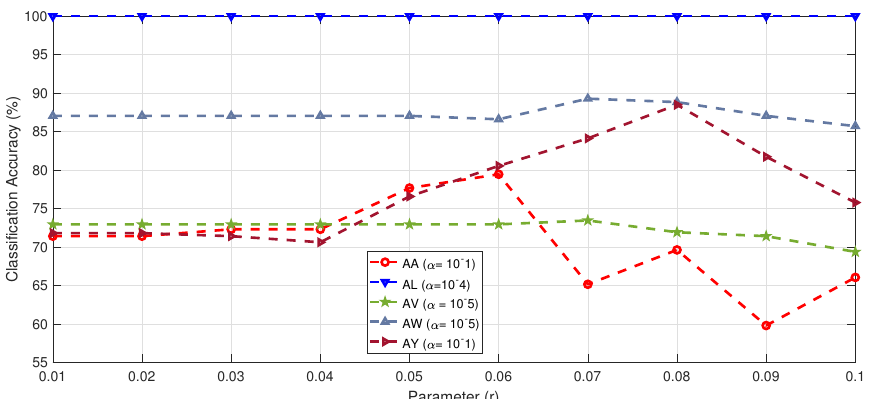
Figure 3. Classification accuracy of all subjects from Dataset IVa with respect to parameter r and best value of α